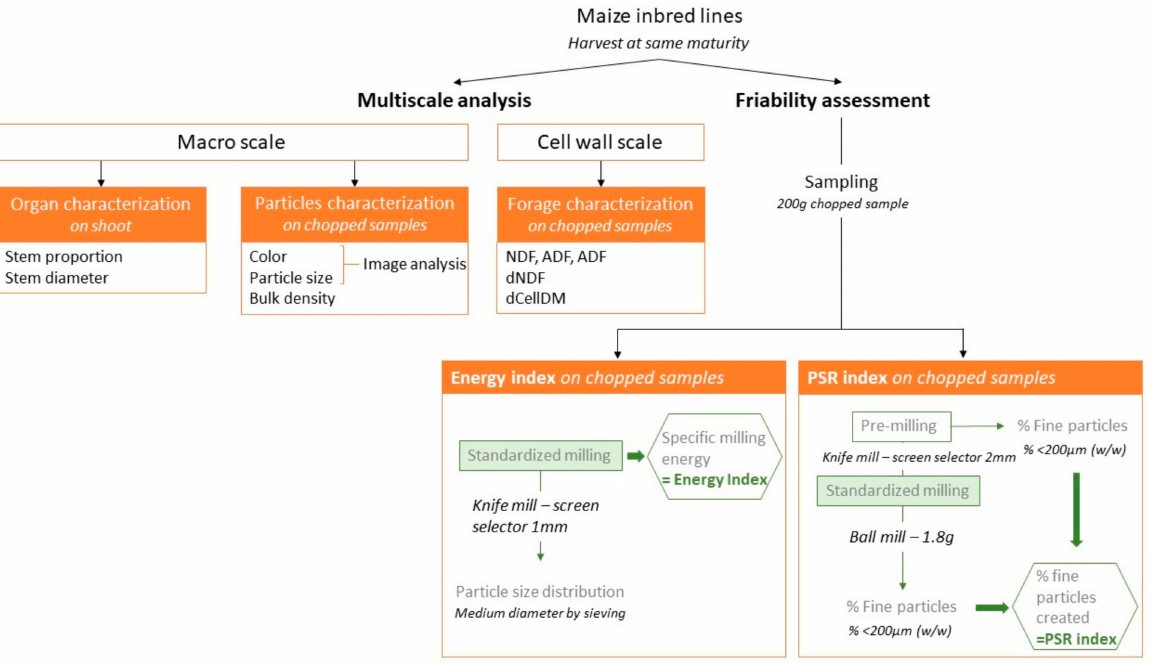
Figure 1. Experimental design with a focus on the friability assessment